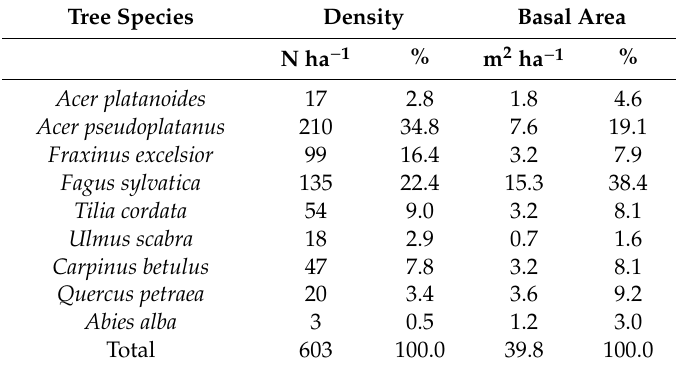
Table 1. Species composition and basic characteristics of living trees (dbh ≥ 4 cm) on the permanent research